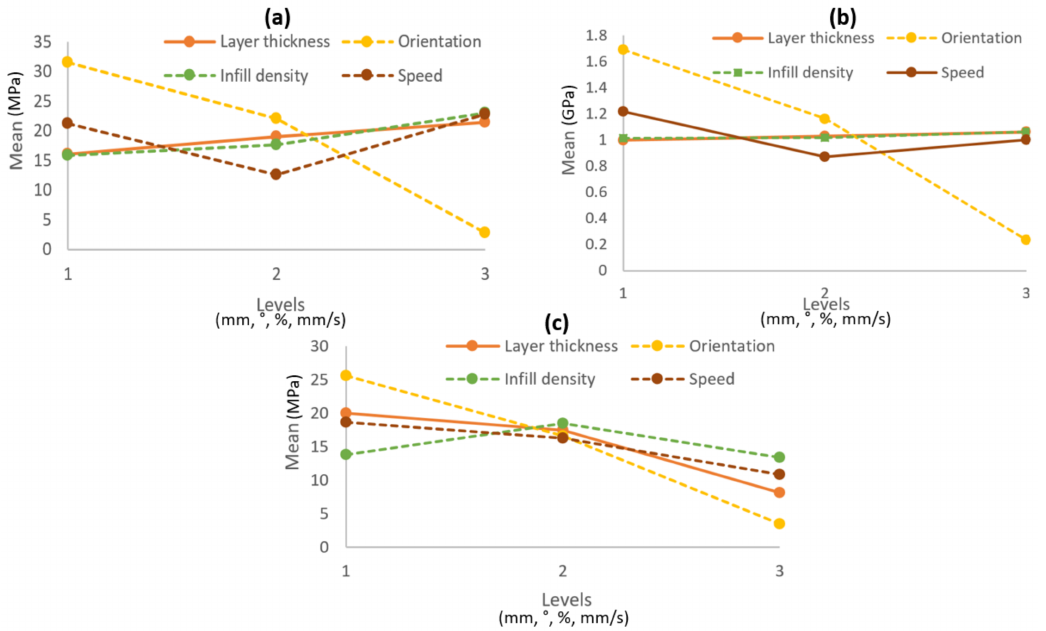
Figure 7. Main effect plot of means for ( a ) tensile strength ( b ) Young’s modulus and ( c ) flexural